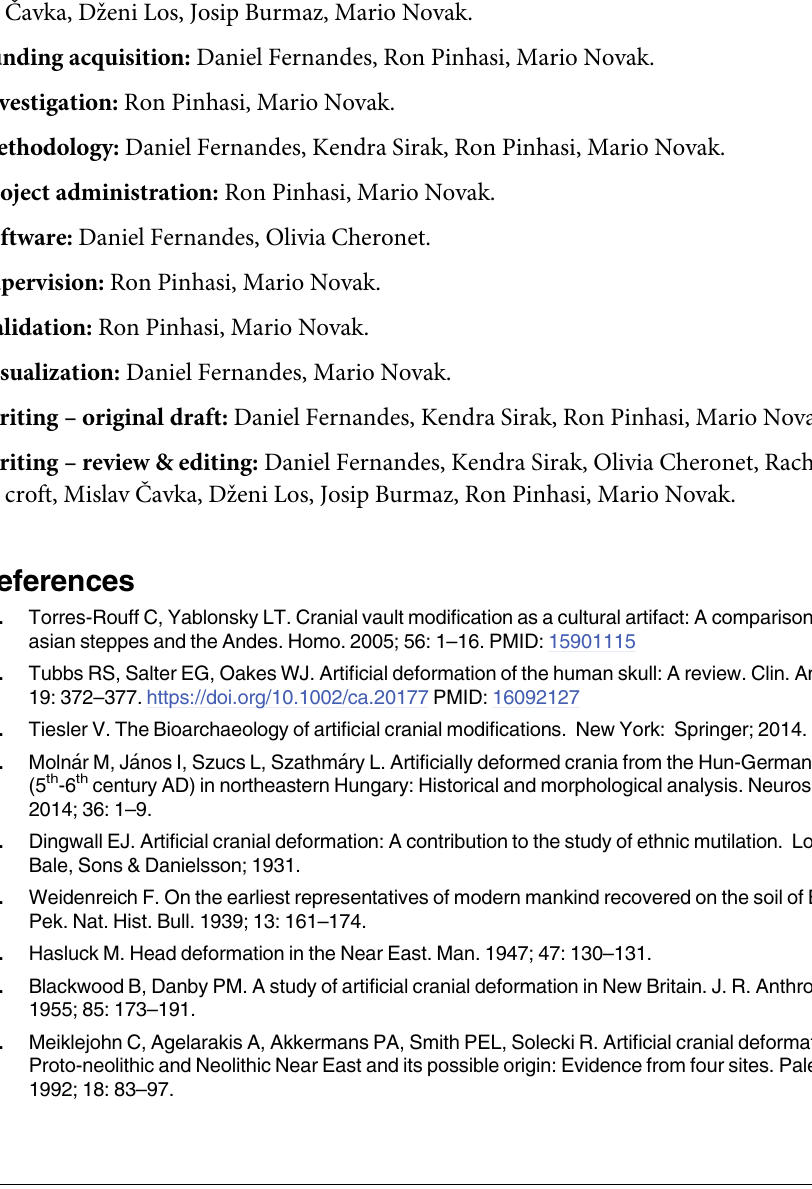
S1 Fig. Principal component analysis replicating Fig 4A on a reduced dataset composed of the combined 15,698 SNPs of the three studied